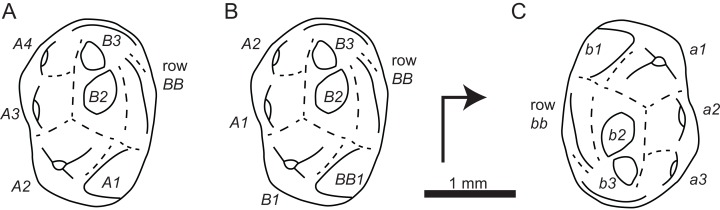
Sketch drawings of specimen BDUC J 3 referred to Millsodon (Middle Jurassic, England), after Butler & Hooker (2005: Fig. 3C).(A) Interpretation of Butler & Hooker (2005); (B) Interpretation of Hahn & Hahn (2006); (C) Interpretation proposed here. Right-angled arrow indicates mesial extremity and lingual side. Letters in italics correspond to cusp nomenclature.